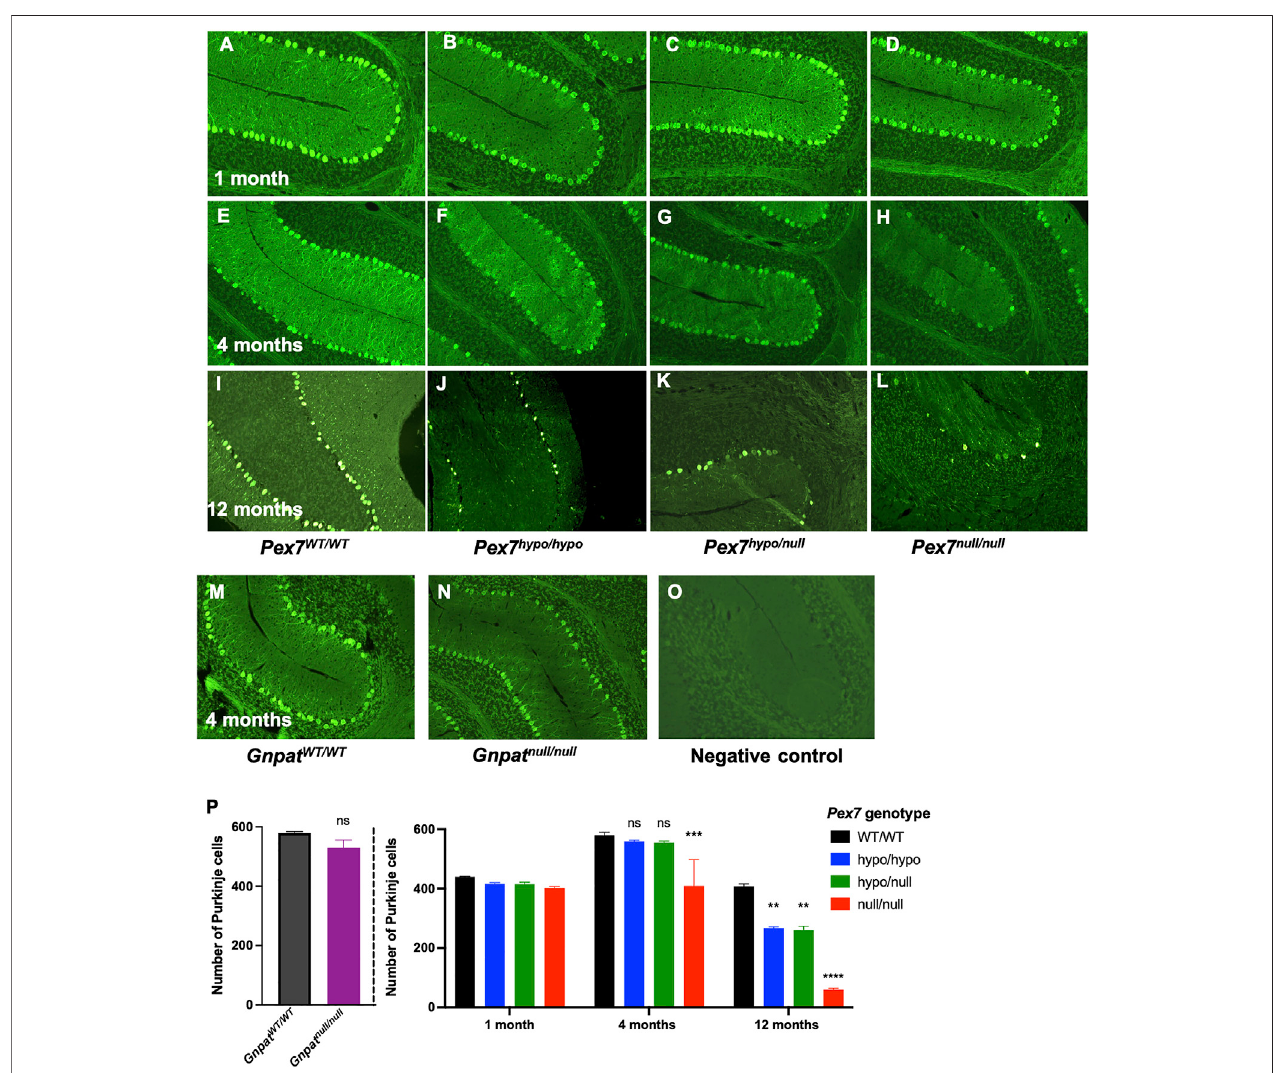
FIGURE7| ProgressivecerebellarPurkinjecellslossovertimein Pex7 de fi cientmice.SagittalsectionsofcerebellumshowedlossofPurkinjecellsinthecerebellum of Pex7 de fi cient mice at 4 (E – H) and 12 months of age (I – L) using anti-Calbindin Immuno fl uorescence staining Negative control includes Pex7 WT/WT section without primary Calbindin antibody (O) . No loss of Purkinje cells in Pex7 de fi cient mice at 1 month of age (A – D) or in Gnpat null/null mice (M, N) . Quanti fi cation of Purkinje cells in Pex7 and Gnpat de fi cientmiceincomparisontotheirlittermatecontrolsrevealedsigni fi cantdecreaseinPurkinjecellsnumberin Pex7 de fi cientmice (P) .Thesevere model ( Pex7 null/null mice) showed the most signi fi cant decrease in Purkinje cells numbers, with the lowest number of Purkinje cells at 12 months of age using anti- Calbindin Immuno fl uorescence staining. * p < 0.05, ** p < 0.01, *** p < 0.001 (Scale bar = 100 μ m), ( n = 3-4 per genotype).